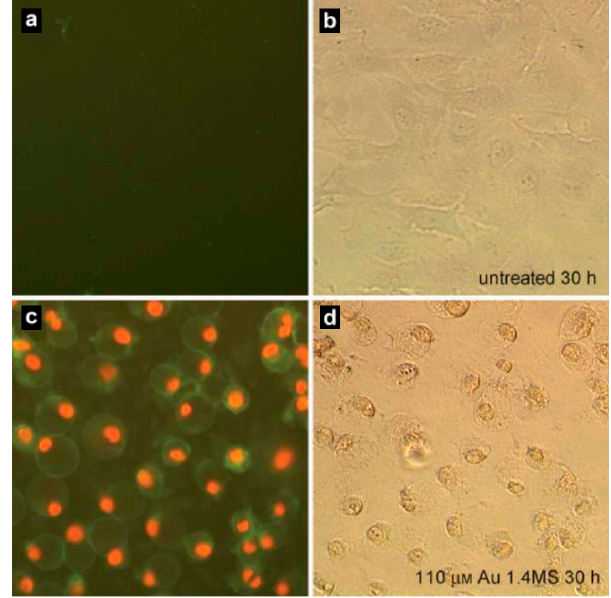
Figure 4. Fluorescence pictures of HeLa cells for the detection of apoptosis (annexin V,